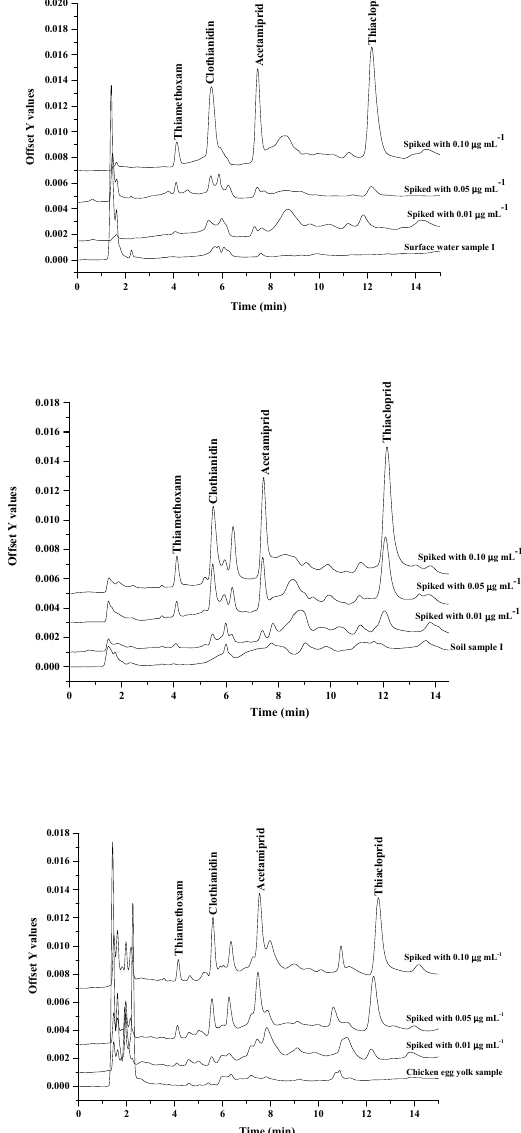
Figure 6. The overlaid chromatograms of sample and spiked samples.